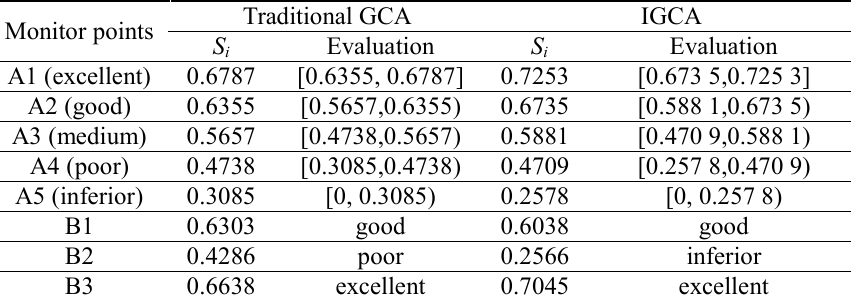
Table 3. Power quality evaluation